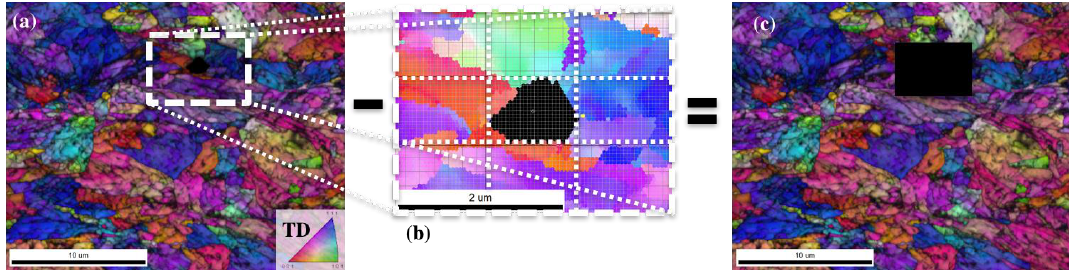
Figure 6. Schematic representation of orientation selection on an overlapped image quality and inverse pole figure map; ( a ) complete region of analysis, ( b ) region selected around the void with faces approximately equal to three times the void diameter; and ( c ) remaining region of analysis. The rolling direction is along the horizontal axis and the normal direction is along the vertical direction.